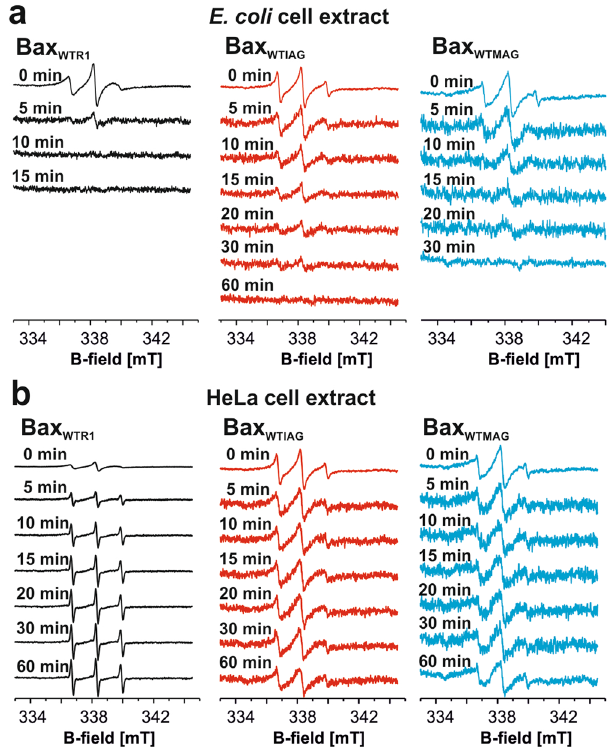
Figure 5. Chemical stability of the nitroxide labels in cell extracts. ( a,b ) cw spectra of Bax WTR1 , Bax WTIAG and Bax WTMAG after incubation with E . coli ( a ) or HeLa ( b ) cell extracts. The final cell dilution factor is 6-fold (see Methods). Data on the stability of Gd-DOTA in cell extracts is given in Supp. Fig.